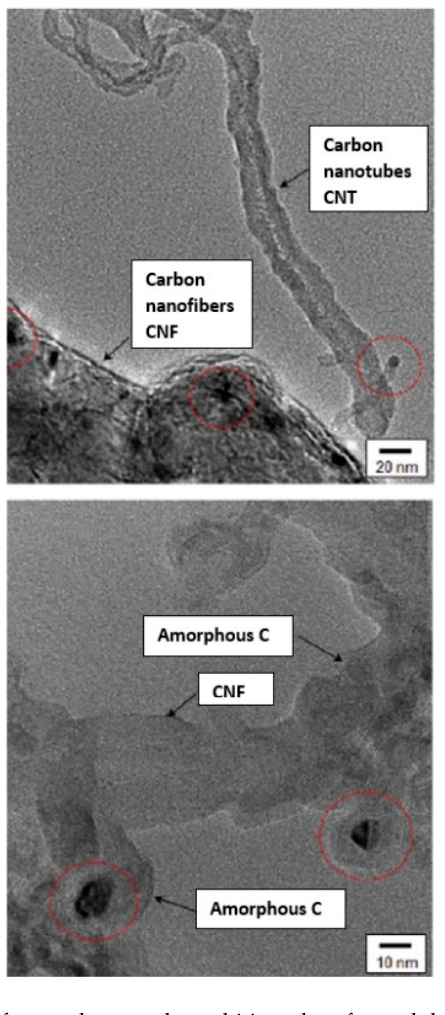
Figure 17. TEM images of amorphous and graphitic carbon formed during glycerol reforming.